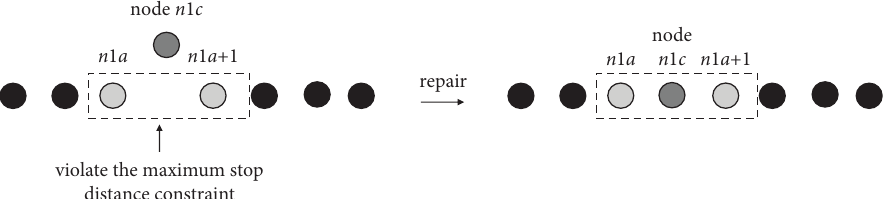
Figure 3: Situation 1 of the stop distance repair